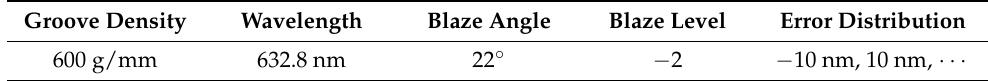
Table 2. Diffraction grating parameters.